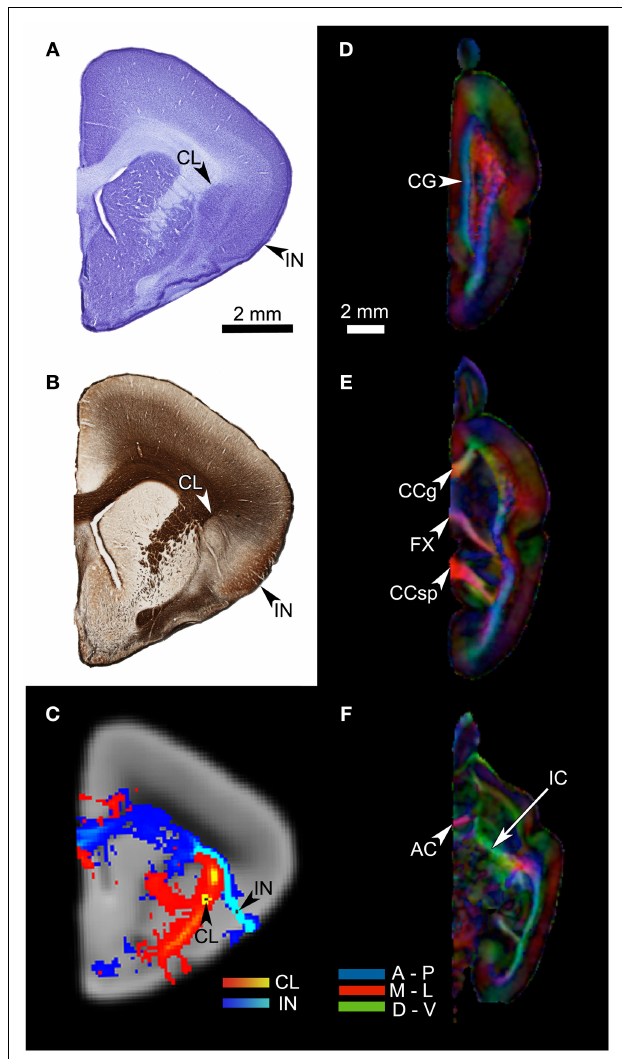
FIGURE 1 | (A) A coronal section of the Microcebus murinus brain, stained for cell body with the cresyl violet Nissl technique.The arrows point to the claustrum (CL) and the insula (IN). (B) An adjacent section, processed with the Gallyas silver staining technique, showing fiber distributions. Note the external capsule segregating the claustrum from the putamen, and the extreme capsule barely separating the claustrum from the insula. (C) A coronal cross-section of the HARDI data, at the level and cutting plane similar to those of the histological sections.The arrows indicate the locations of the claustral and mid-insular seeds.The red-yellow tract originates from the claustral seed, whereas the blue-light blue tract arises from the mid-insular seed. (D–F) The fractional anisotropy (FA) map of the HARDI data, in horizontal planes.This map reflects the distribution of fiber tracts in the brain tissue, with the colors representing fiber directions (blue = anterior-posterior; red = medial-lateral; green = dorsal-ventral).The map clearly shows a number of major fiber bundles, such as the anterior commissure (AC), cingulum bundle (CG), corpus callosum, genu (CCg), corpus callosum, splenium (CCsp), fornix (FX), and internal capsule